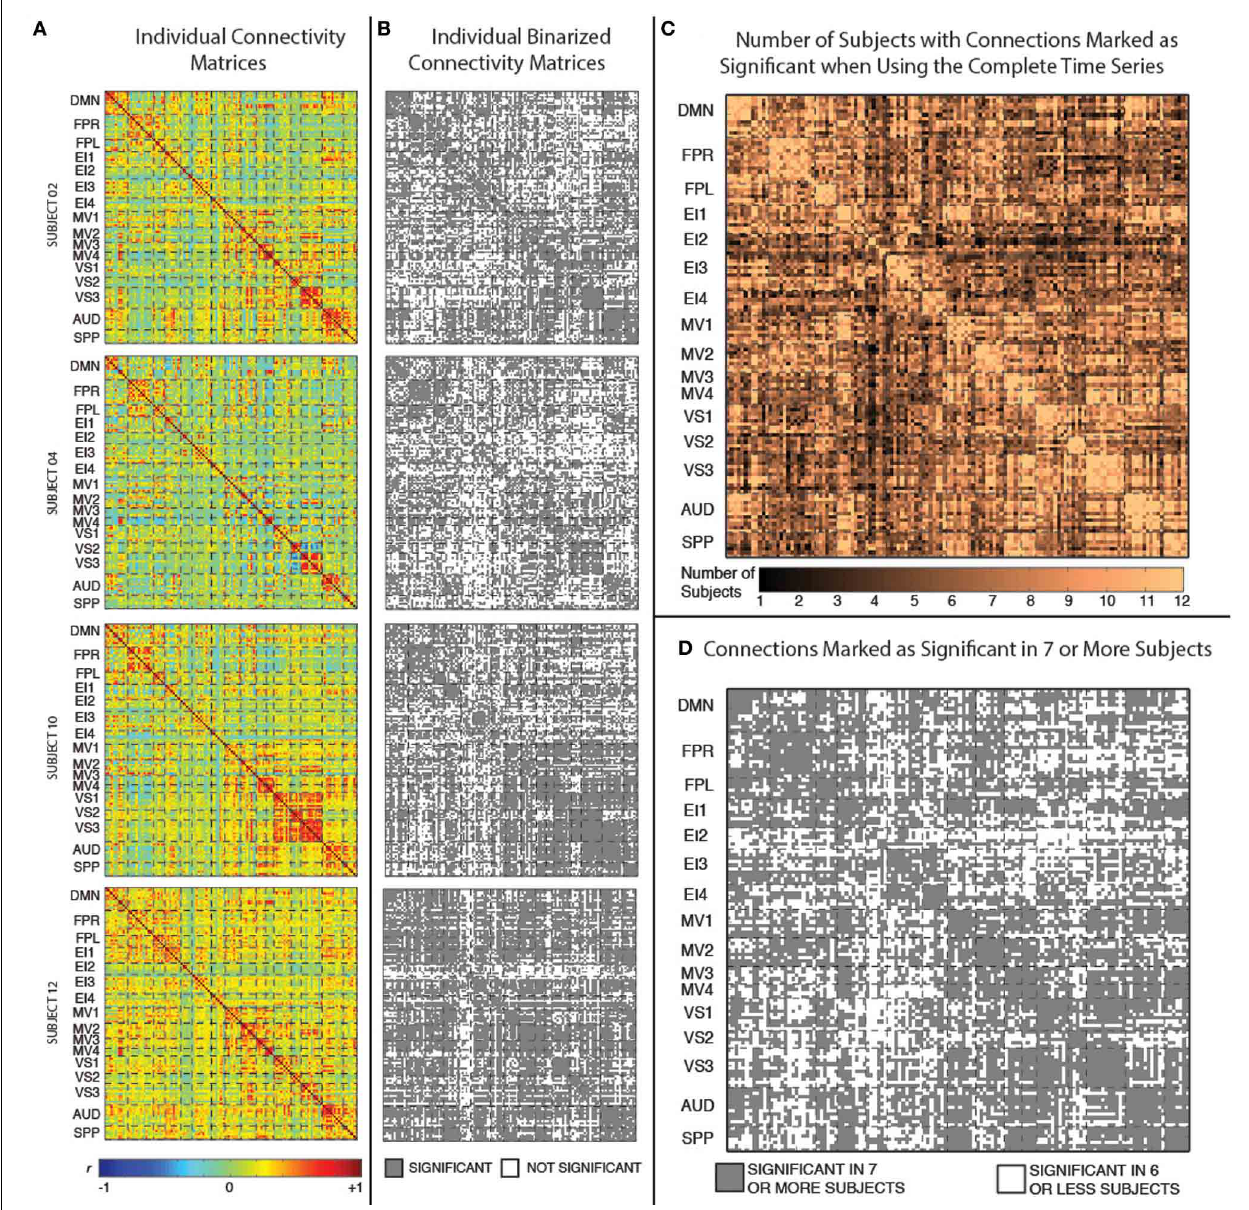
FIGURE 3 | (A) Weighted connectivity matrices in terms of Pearson’s correlation ( r ) for four representative subjects when the complete time series (3950 data points) enter the analysis. (B) Binary connectivity matrices for the same four representative subjects after statistical